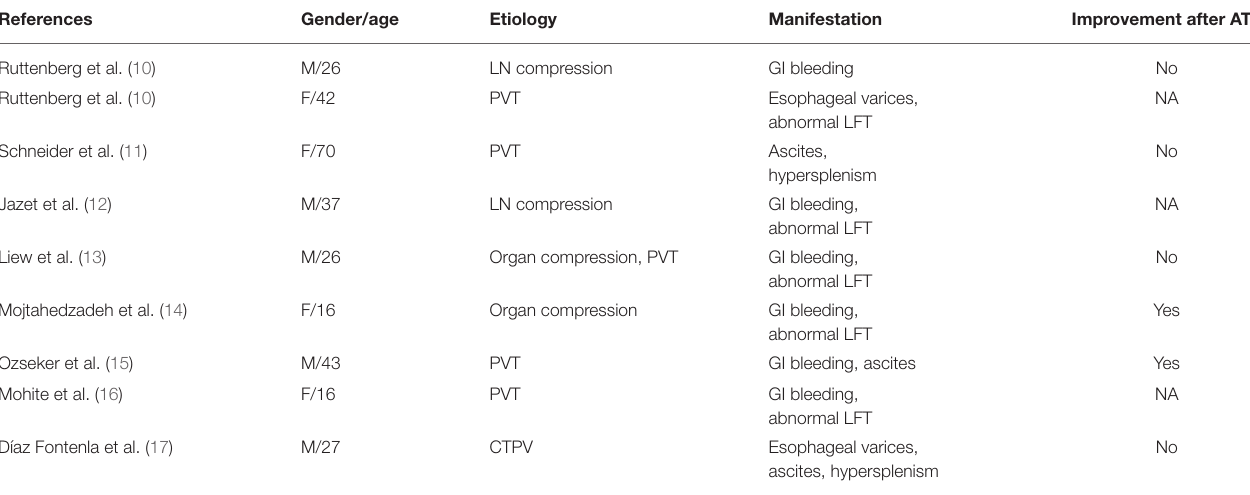
TABLE 1 | The clinical characteristics of patients with portal venous obstruction/stenosis caused by abdominal